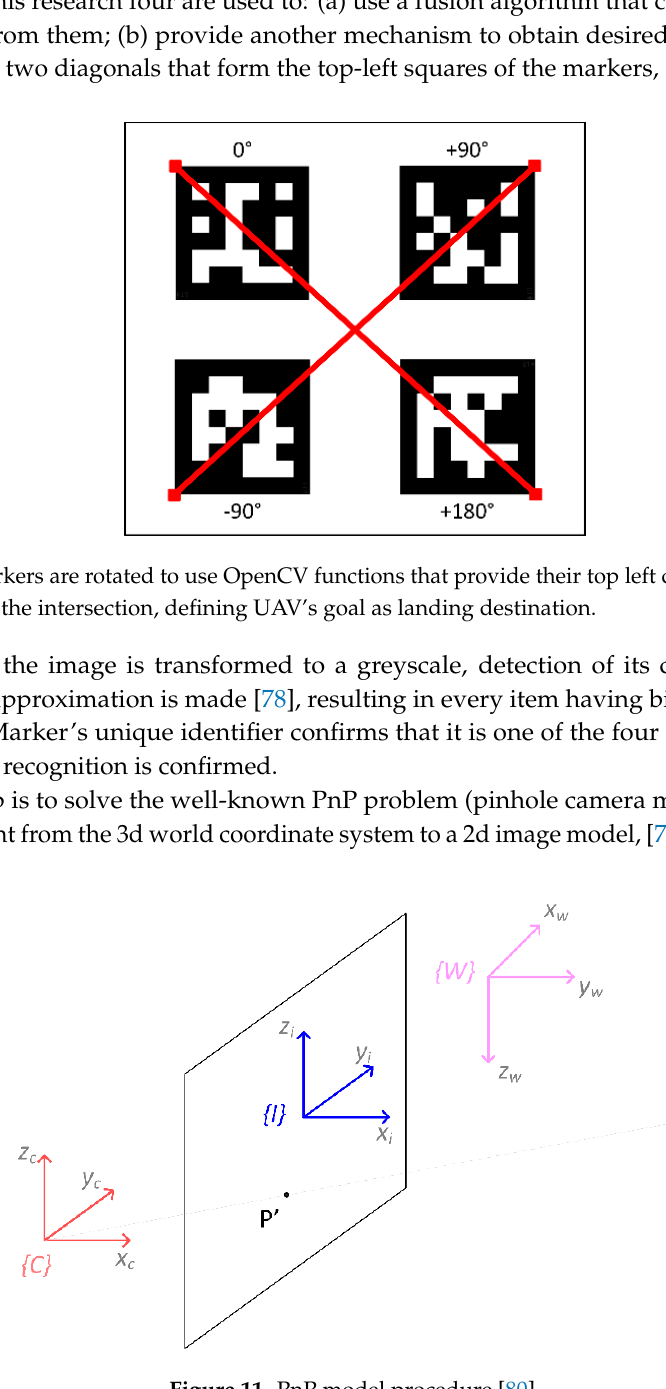
Figure 11. PnP model procedure [80].